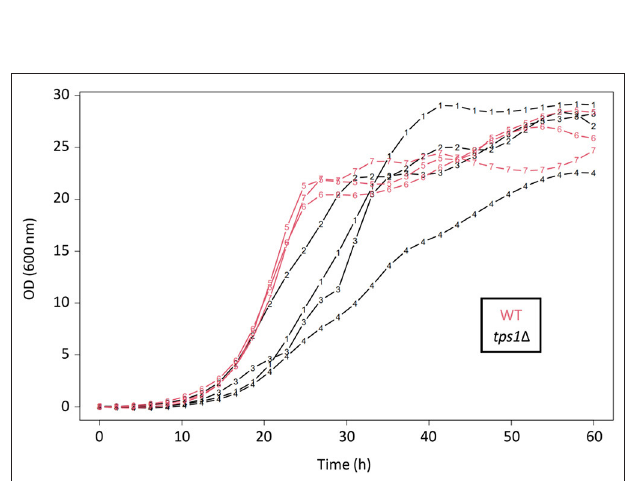
FIGURE 5 | Batch cultures of the tps1 1 mutant in controlled bioreactors. OD (600nm) values as a function of time (hours), for four independent replicates of the tps1 1 strain (black; 1–4) and three replicates of the WT strain (red; 5–7). These strains were grown for several days on galactose minimal medium, in controlled bioreactors. Both are prototrophic CEN.PK strains. The WT replicates showed a typical diauxic growth, with a metabolic shift around 25h. For the sake of clarity, raw OD curves were fitted as described in